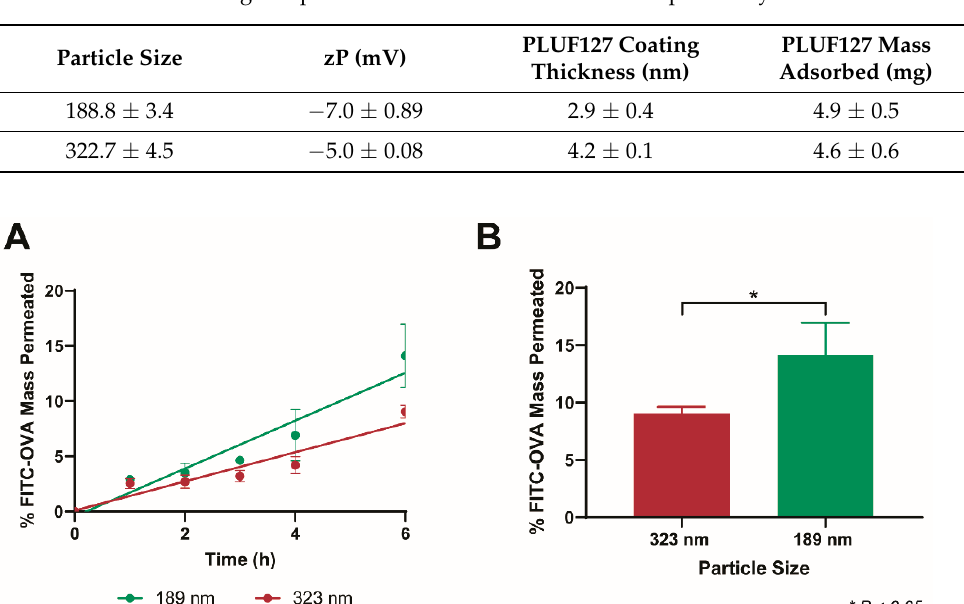
Figure 7. Size-dependent mucus diffusion of PEG-PLGA-NP in BSM ( A ). Comparative permeation of both nanoparticle systems at 6 h ( B